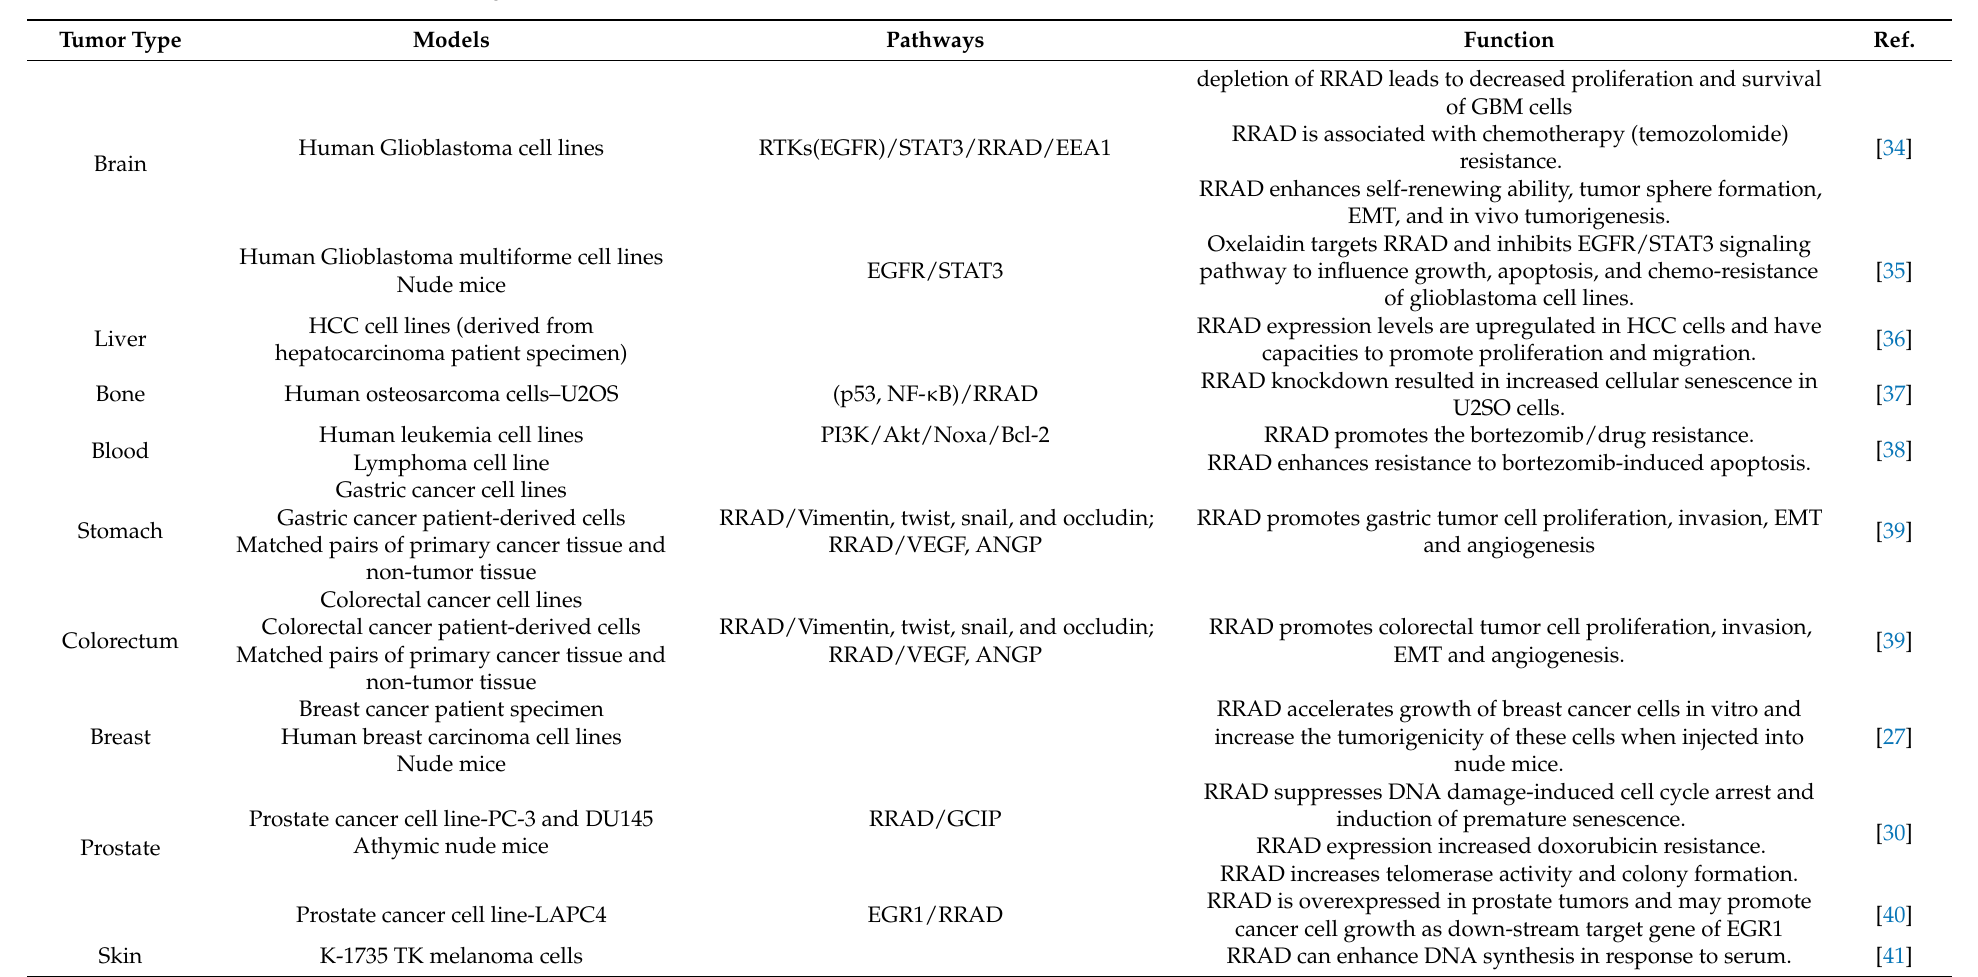
Table 2. Oncogene effect of